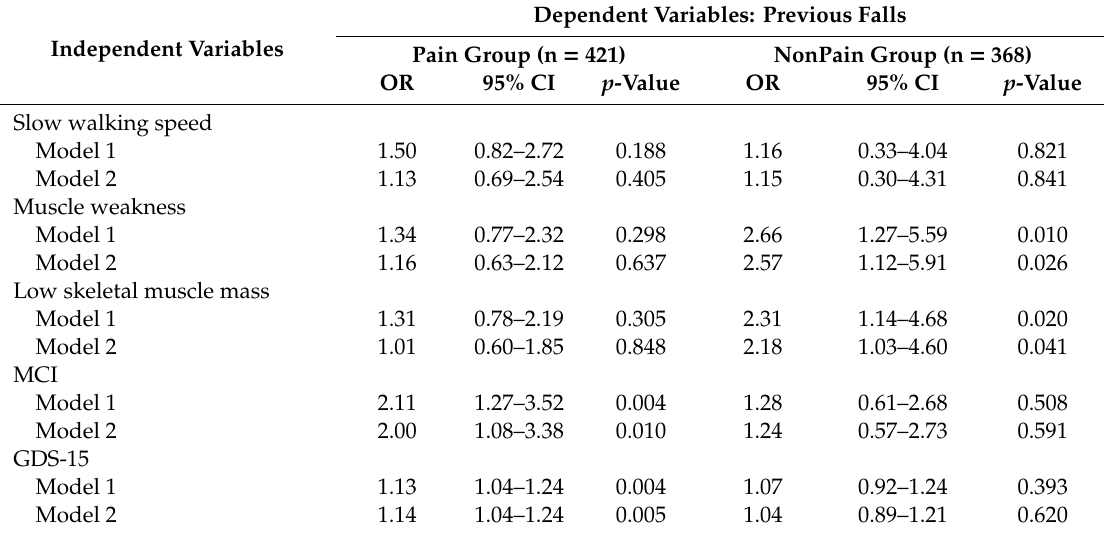
Table 2. Multivariable logistic regression analyses of the relationships between falls and physical, cognitive and emotional factors in the pain and nonpain groups. Dependent Variables: Previous Falls Independent Variables Pain Group (n = 421) NonPain Group (n =